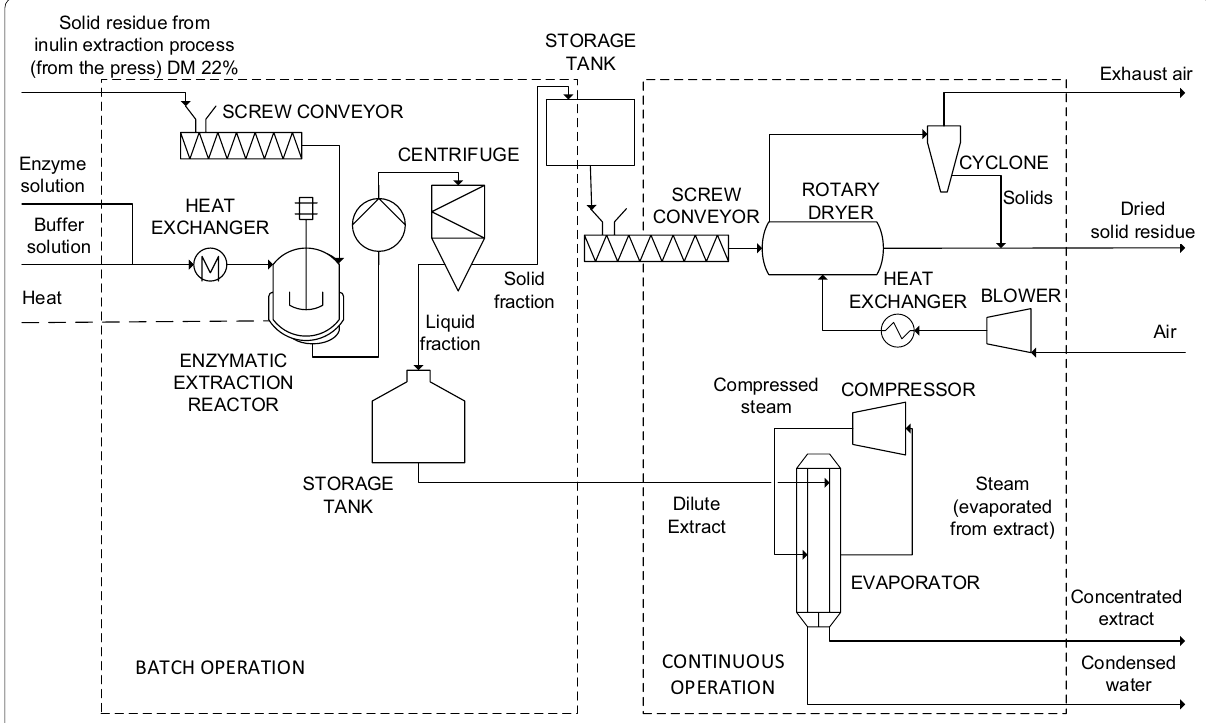
Fig. 1 Baseline process (scenario 1) for the production of antimicrobial extracts from chicory biomass following inulin